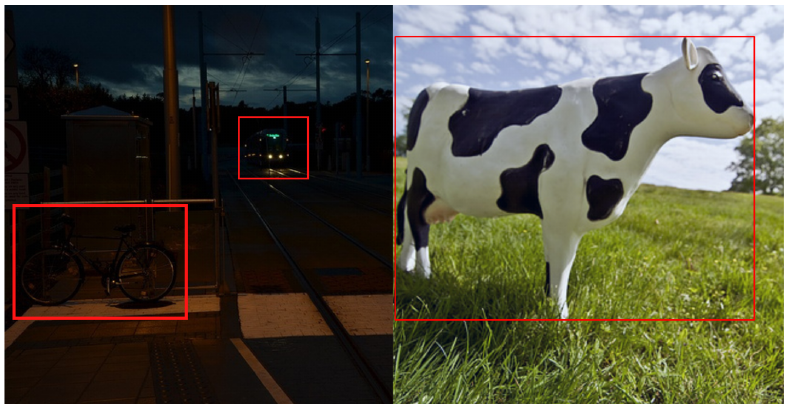
Figure 2. Graphical illustration of object detection in a challenging environment (left image), whereas object detection in a conventional environment is shown in the right image. There are two objects: bicycle and bus are present in the challenging left image while the cow is a targeted object in the right image.